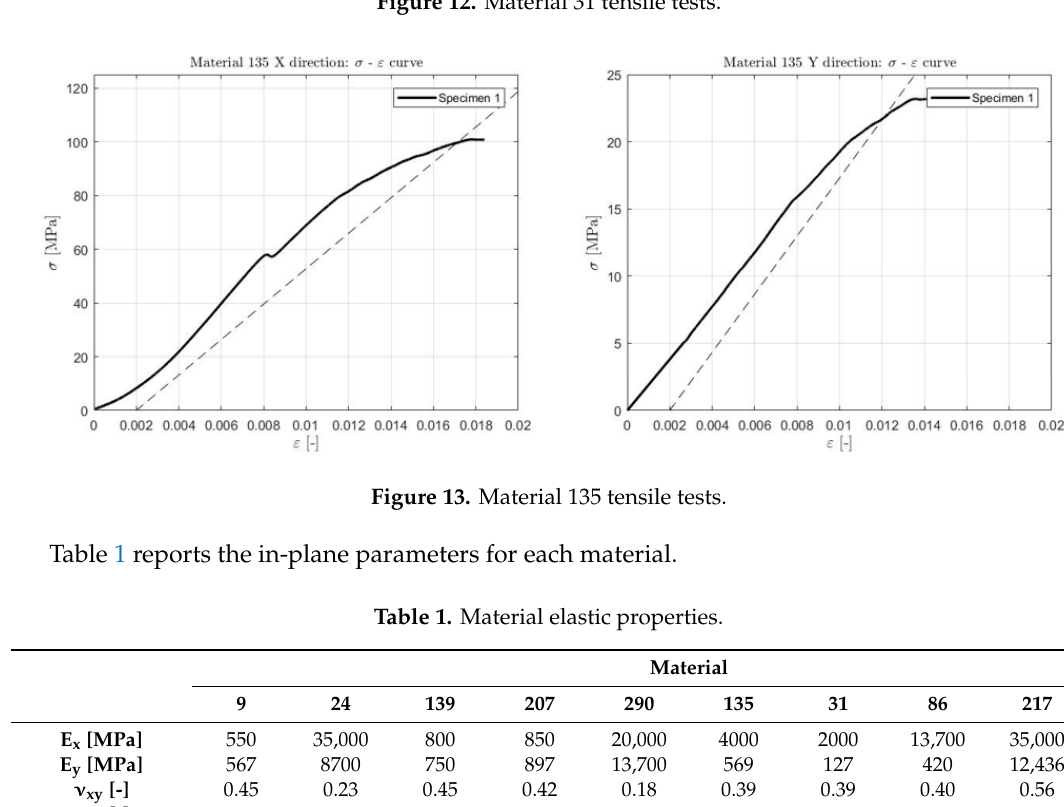
Figure 12. Material 31 tensile tests.